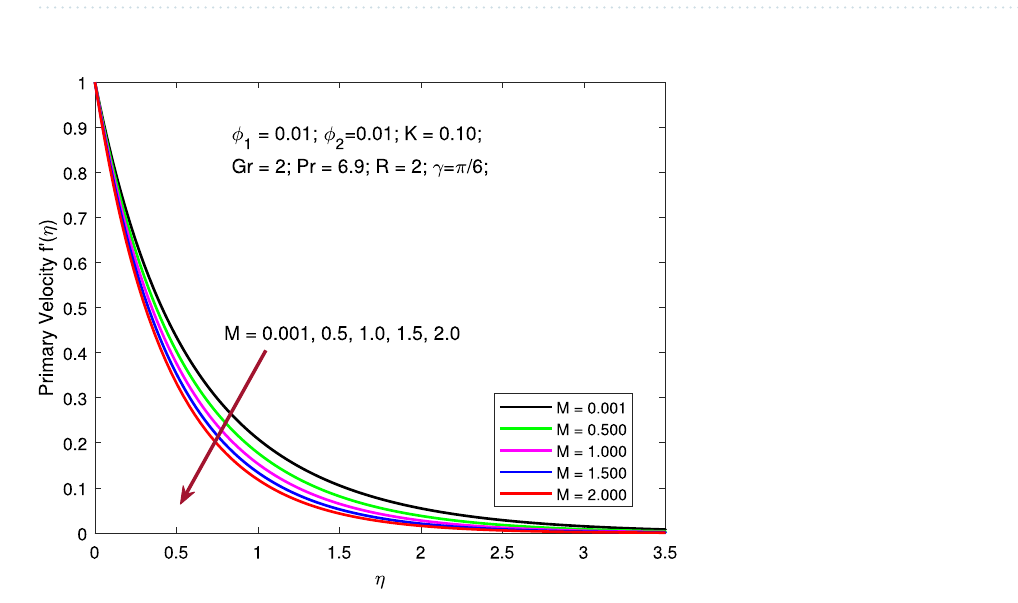
Figure 4. Variation of primary velocity with MF